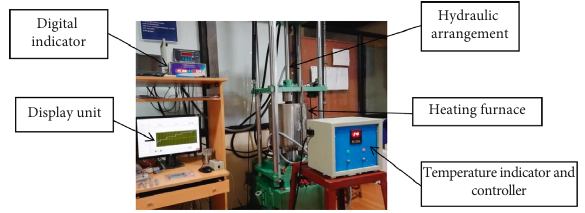
Figure 8: Time-dependent creep experimental test